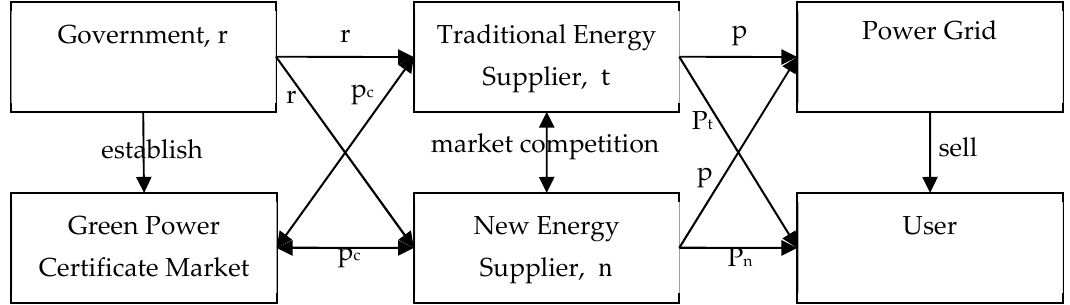
Figure 1. Renewable energy investment and production model.